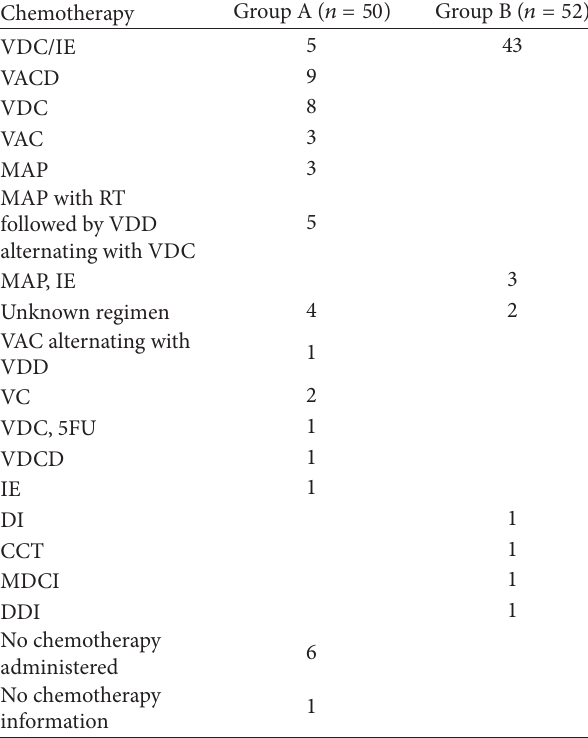
Table 2: Chemotherapy regimens ( 𝑛 = 102 ).